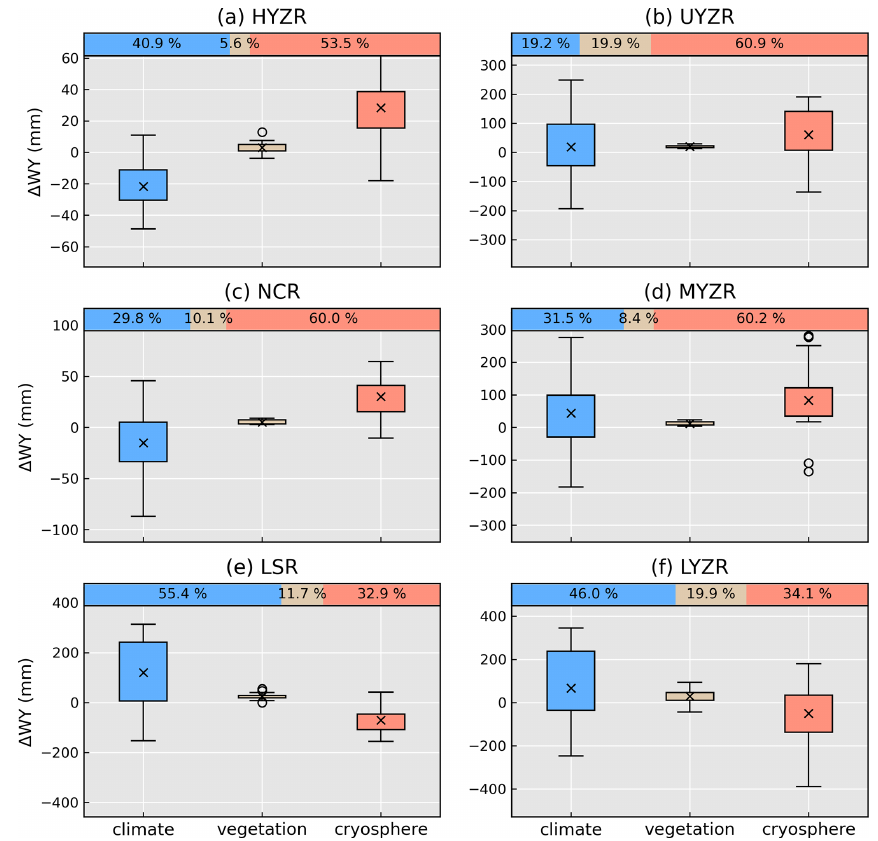
Figure 5. Attribution analysis of magnitude increases in water yield due to climate ( (cid:49) WY c ; blue box), vegetation ( (cid:49) WY v ; tan box), and cryosphere ( (cid:49) WY g ; red box) and their relative contributions (the bar with colors on the top) in each basin. The black cross (x) shows the average of water yield deviations (see Fig. S5) in each box